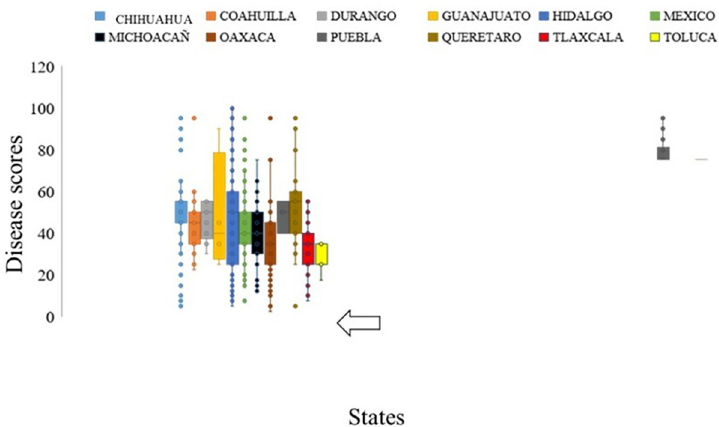
Fig 4. Figure presenting disease severity of Mexican Wheat landraces belonging to different states against stem rust fungus. Accessions from ‘Tlaxcala and Toluca’ showed lowest disease score as compared to the ones from other states. X-axis presents states and disease score was plotted on